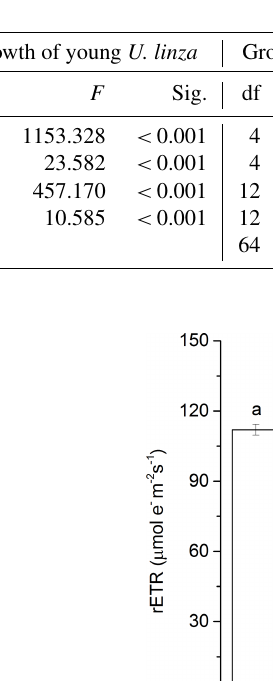
Table 3. Repeated analysis of variance for the effects of culture time on length changes in young and adult U. linza grown under various p CO 2 and nutrient conditions. Time ∗ p CO 2 means the interactive effect of time and p CO 2 , Time* nutrient means the interactive effect of time and nutrients, and Time ∗ p CO 2 ∗ nutrient means the interactive effect of Time, p CO 2 and nutrients; df means degree of freedom, F means the value of F statistic, and Sig. means p value.